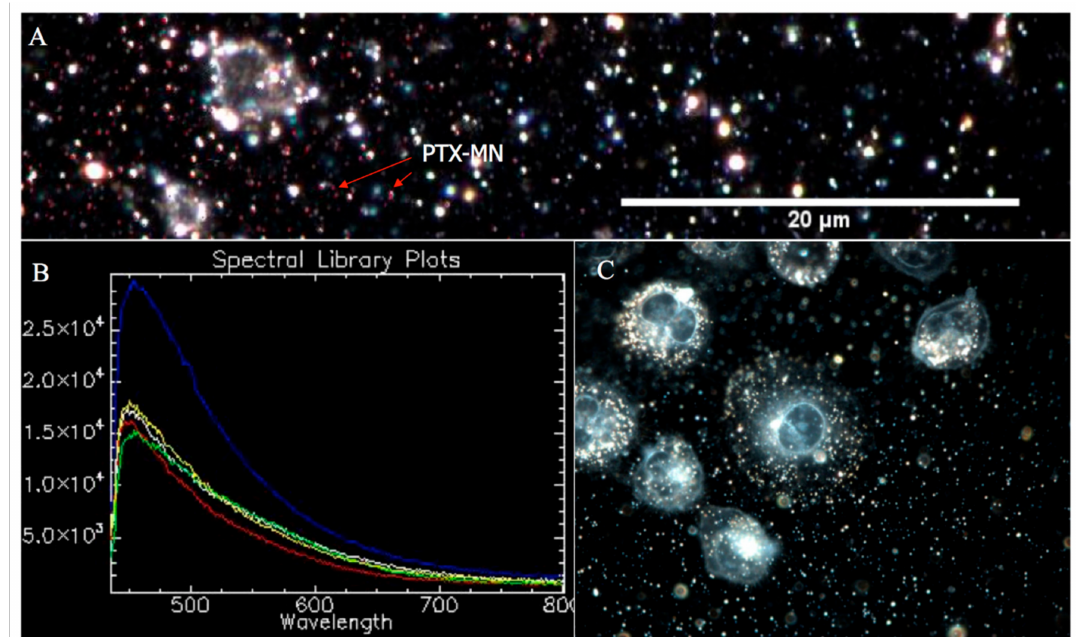
Figure 7. CytoViva hyperspectral microscopy data: ( A ) PTX-MN spectrum, filtered against drug-free nanoparticles spectrum (inset); ( B ) PTX-MN mapping; and ( C ) MDA-MB-231 cells in the presence of